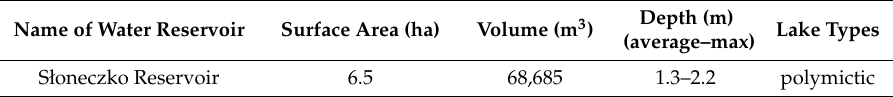
Table 1. Morphometric characteristics of the